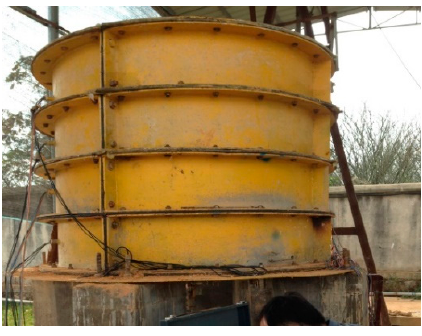
Figure 1. Model test equipment.